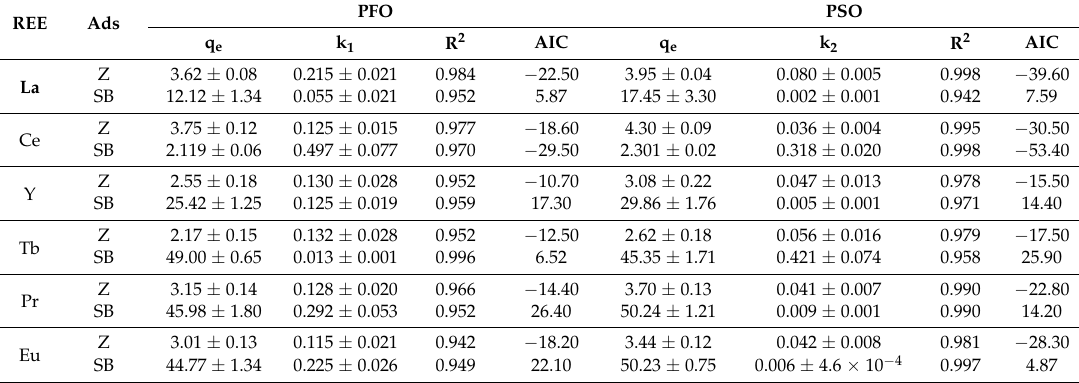
Table 6. Fitting parameters, square errors and AIC for PFO and PSO for the adsorption kinetics with the different adsorbents (Ads): zeolite (Z), suspended biomass (SB), for the single solute